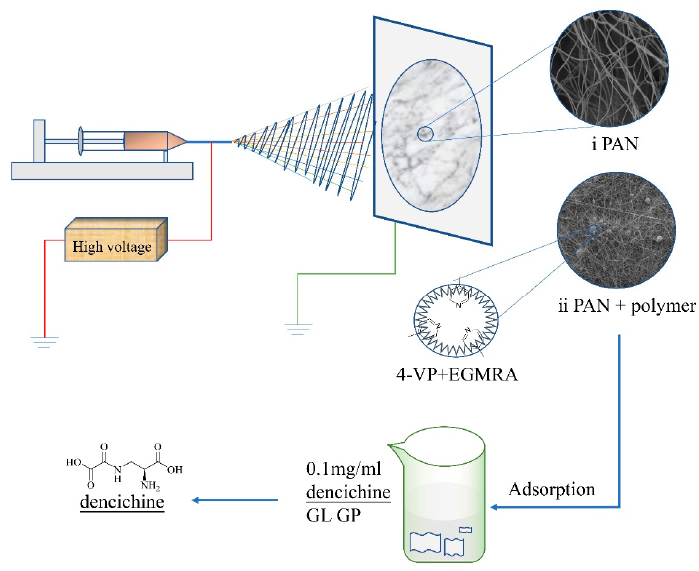
Figure 1. The scheme for preparing the RCMs.